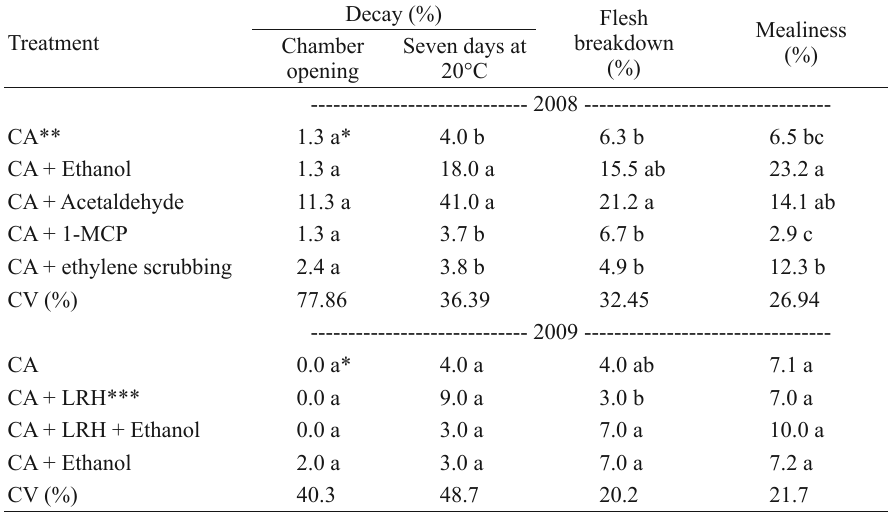
Occurrence of decay right after removal from storage and incidence of fl esh breakdown and mealiness after seven days of post-storage exposure to 20 °C in ‘Royal Gala’ apples stored for eight months in controlled atmosphere. Santa Maria, 2008 and